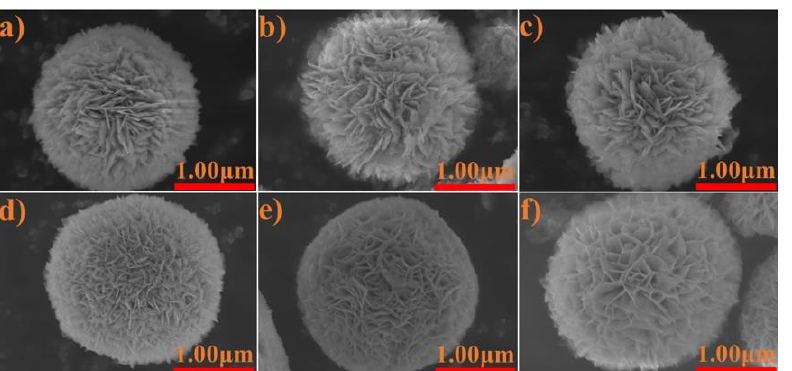
Figure 6. SEM images of fresh ( a ), used ( b ) and regenerated ( c ) BiOCl and fresh ( d ), used ( e ) and regenerated ( f ) BiOBr.